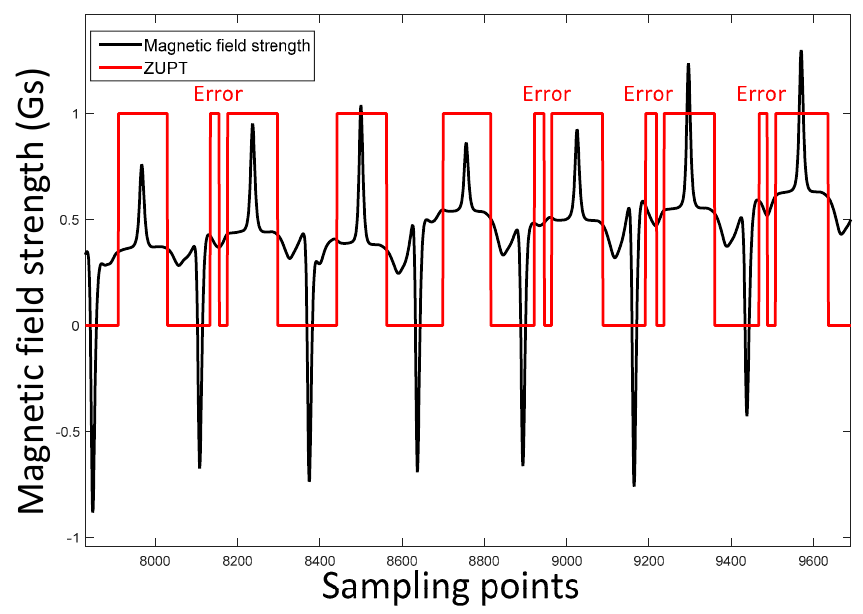
Figure 9. ZUPT errors and the magnetic field strength waveform.